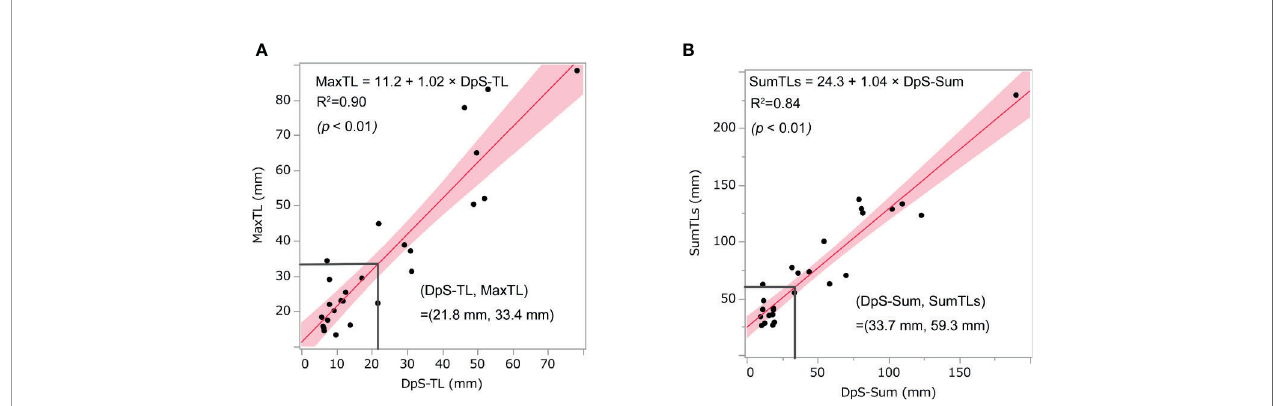
FIGURE 2 | Relationship between post-treatment tumor burden and baseline tumor burden. The scatter diagrams show the relationship between (A) MaxTL and DpS-TL and (B) SumTLs and DpS-Sum. The straight line is the regression line and the shaded section shows the 95% con fi dence interval. MaxTL: the maximum tumor diameter of target lesion, DpS-TL: the maximum shrinkage values of MaxTL during the clinical course, SumTLs: the sum of diameters of target lesions, DpS- Sum: the maximum shrinkage values of SumTLs during the clinical course.